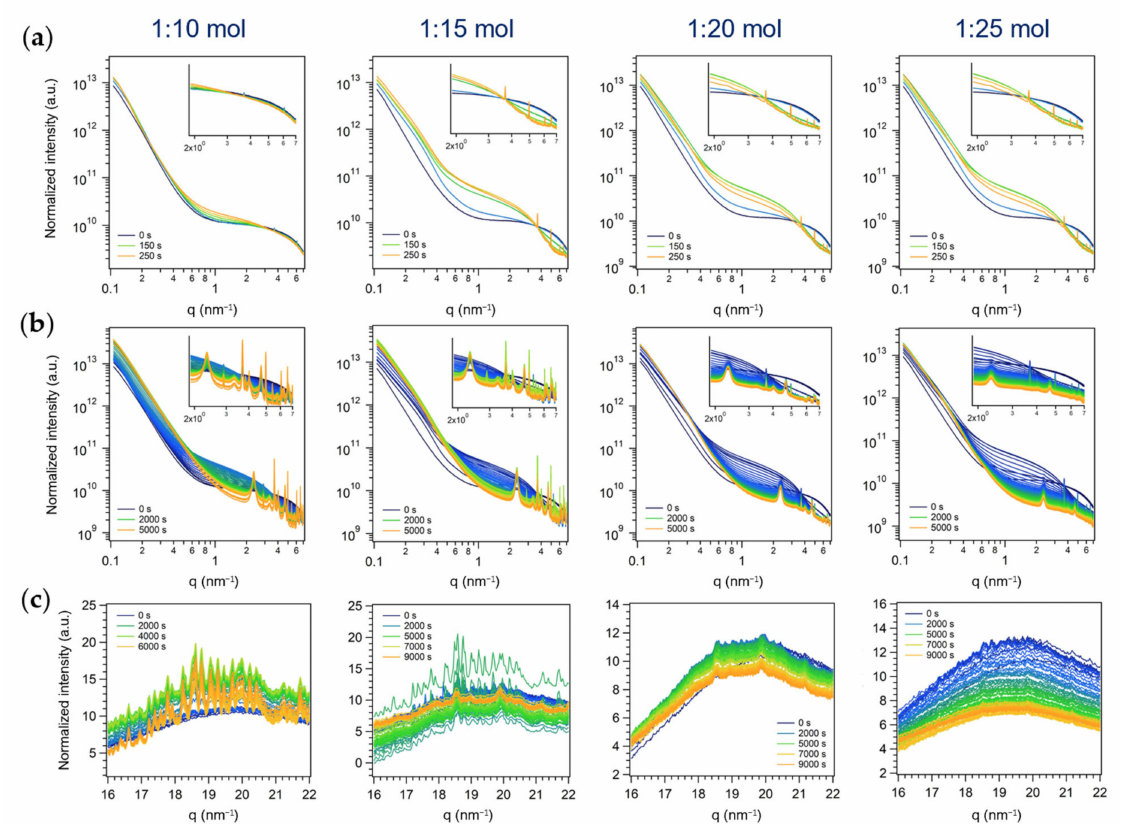
Figure 8. In situ time-resolved ( a , b ) log-log plots of SAXS and ( c ) simultaneous WAXS patterns of the series of experiments performed in ME without the US step with different AHM:HNO 3 molar ratios (second series of experiments). A SAXS pattern every 50 s from the start of acid addition (t = 0 s) to ( a ) 250 s (i.e., corresponding to the end of US step for the first series of experiments) and to ( b ) 5000 s. Insets: zoom on Bragg peaks (1.9–7 nm − 1 ). ( c ) A WAXS pattern every 100 s from the start of acid addition (t = 0 s) to the end of